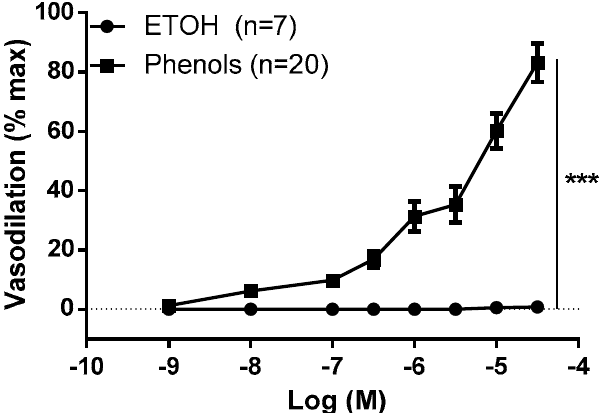
Figure 1. Extra virgin olive oil phenols dilate the resistance mesenteric artery (MA). Phenols from crude extra virgin olive oil (phenols) and the phenol vehicle, ethanol (ETOH), were tested on resistance mesenteric arteries isolated from rats. Data are reported as Mean ± SEM, n (experimental number). Statistical analysis was performed using two-way ANOVA, *** p < 0.001. The vasodilation of EVOO phenols was time-dependent and the maximum e ff ect was reached within 30 min. For the same time period and conditions, no e ff ect was observed for the ethanol (Figure